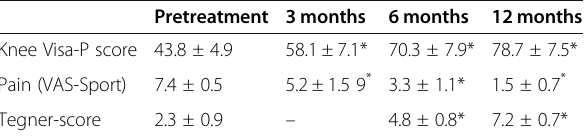
Table 2 Clinical evaluation